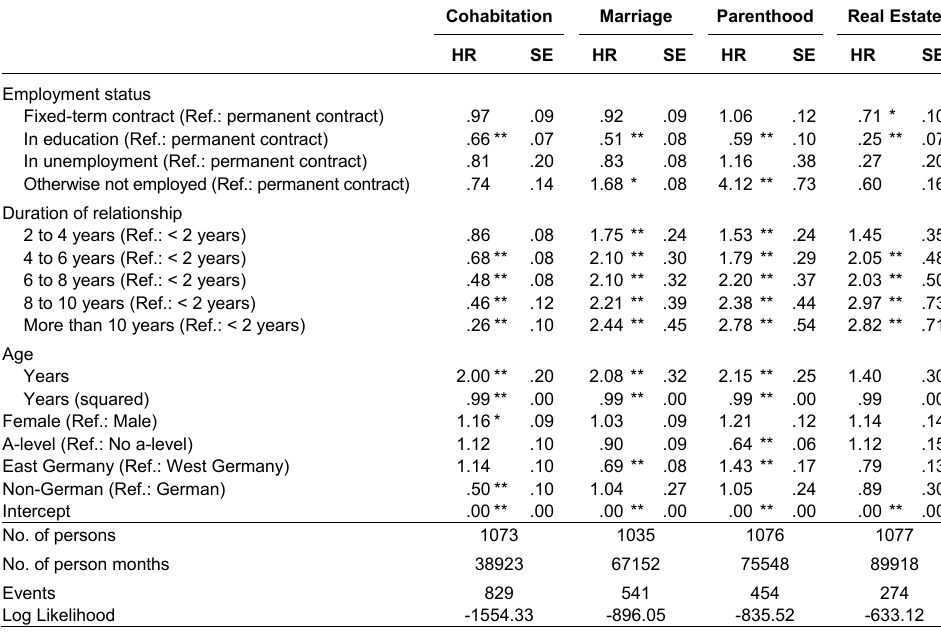
Table 2 : Effects of fixed-term employment on partnership events (piecewise-constant exponential models, hazard ratios and standard errors) Cohabitation Marriage